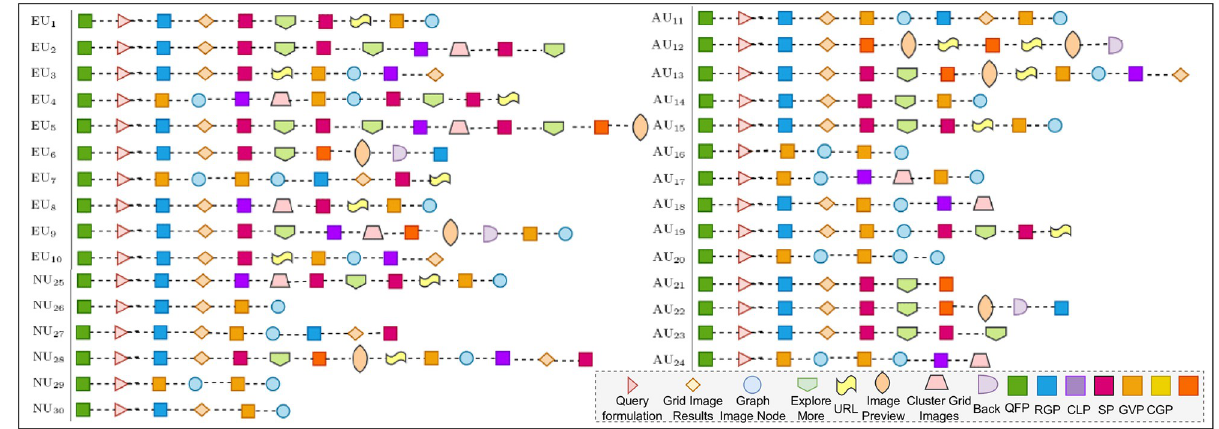
Fig 10. Respondents exploration activity in unstructured task ET 2